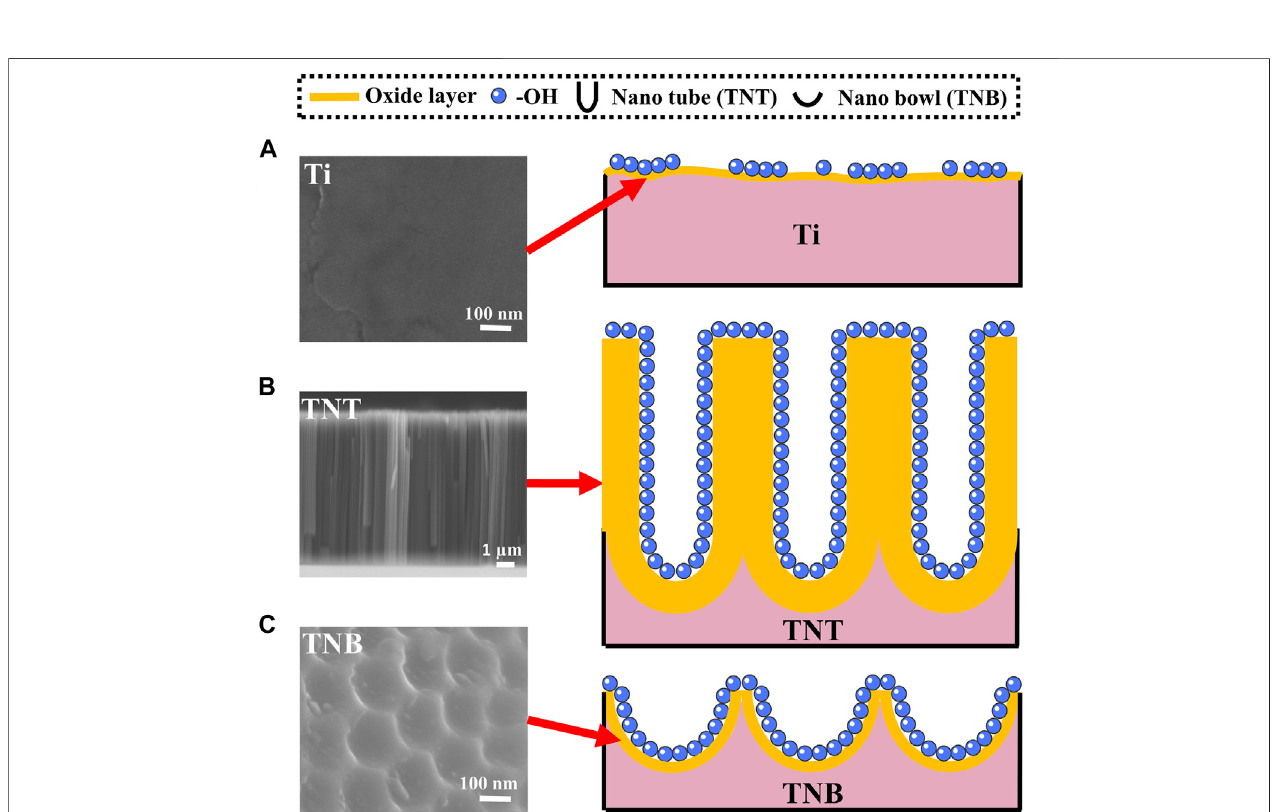
FIGURE 3 | Schematic diagram of surface etching of KOH alkaline solution on (A) Ti, (B) TNT, and (C) TNB.